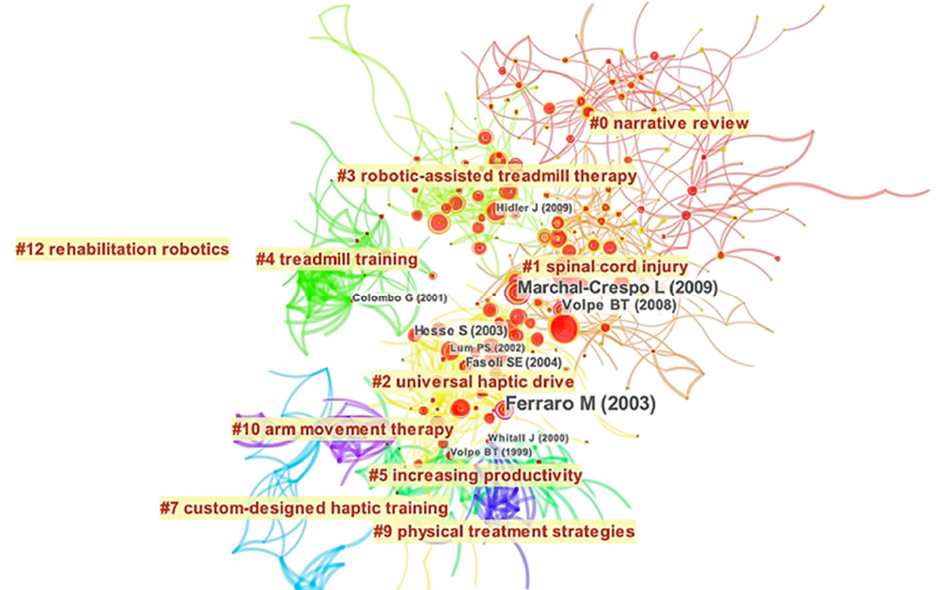
Figure 4. Land-view clusters of the document co-citation network. Table 3. Top 10 clusters in the document co-citation analysis.